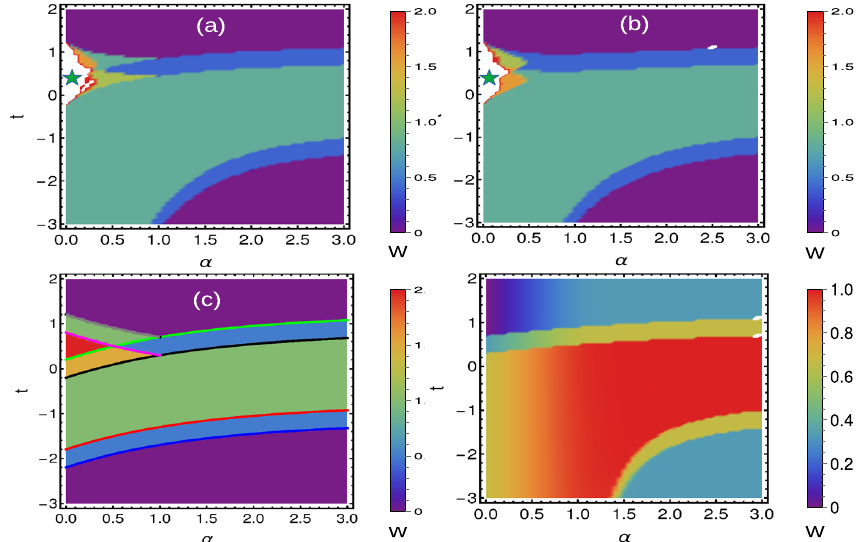
Figure 6. (Color online) Phase diagrams of non-Hermitian SSH chain with periodic boundary conditions. ( a ) Extended-range model with even neighbors. ( b ) Extended-range model with odd neighbors. ( c ) Simple extended-range model with two neighbors ( d ) Long-range model with infinite neighbors. Here the star symbol represents the region of higher WNs, which are less stable compared to their lower WNs.